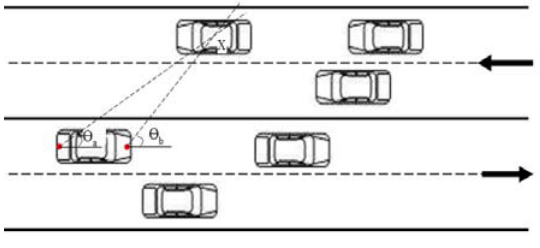
Fig.2. Angle of Arrival